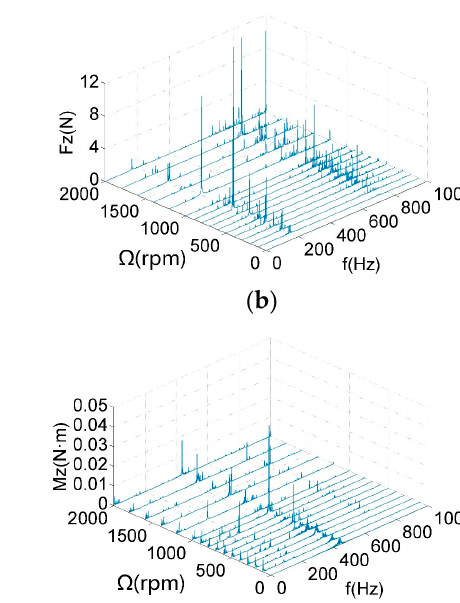
( a ) ( b ) Figure 13. Spectra of micro-vibration signals by WTD and EMD–SG: ( a ) 1800 rpm; ( b ) 2000 rpm. As exhibited in Figure 12, the magnitude of the user tolerance level directly affects the final effect of the signal denoising. In Figure 12a, a reaction wheel generates a large disturbance force at 131.5 Hz owing to the coupling of the harmonic responses and structural modes, which increases the threshold value to filter out some critical frequency features. Some obvious feature frequencies are equally easy to be removed in Figure 12b, such as 20 Hz . As shown in Figure 13, WTD and EMD–SG mainly act on high-frequency of test signals, which appear under-denoising in the low-frequency range and lose